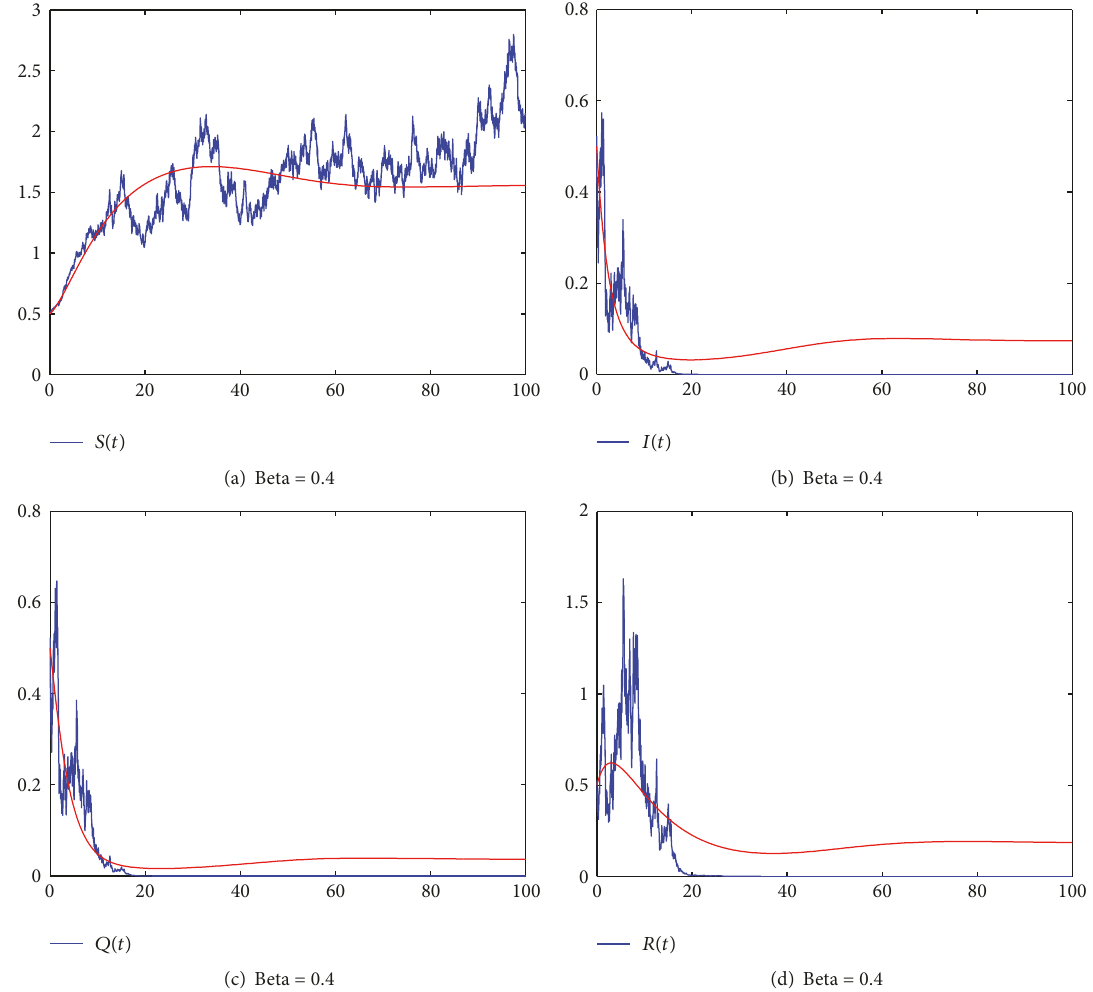
Figure 4: Computer simulation of the paths 𝑆(𝑡), 𝐼(𝑡), 𝑄(𝑡) , and 𝑅(𝑡) for models (1) and (3) for parameter values Λ = 0.2; 𝑑 = 0.1; 𝛽 = 0.7; 𝛾 = 0.2; 𝛿 = 0.2; 𝛼